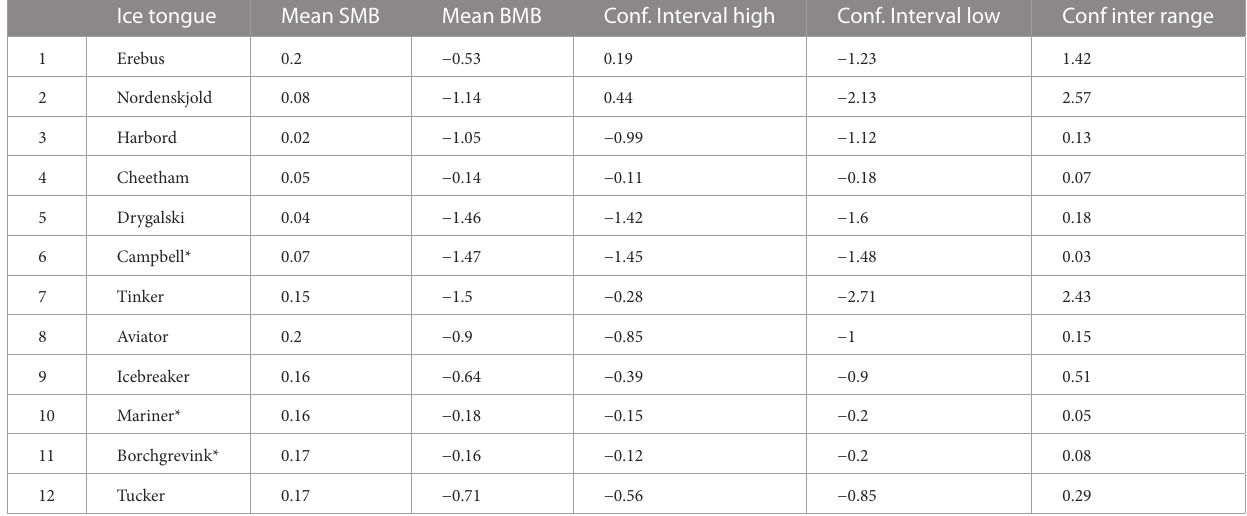
TABLE1 Annualmeanofsurfacemassbalanceandbasalmassbalancewithconfidenceintervalsofalltheicetonguesinthisstudy(moficeyr − 1 ).*:basalmelt